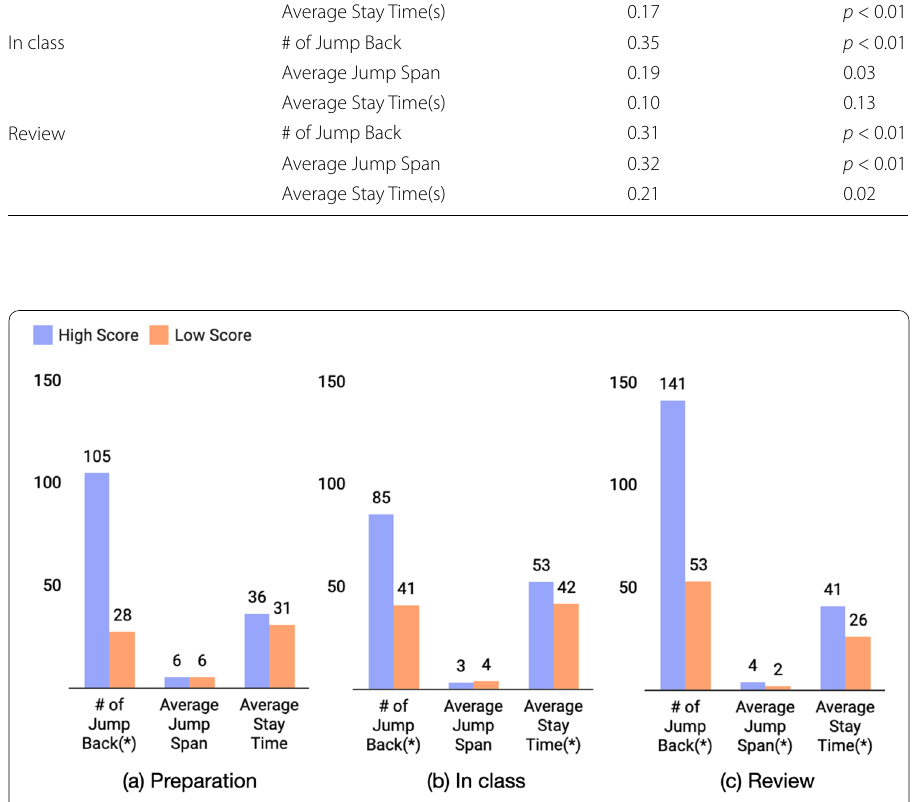
Fig. 9 Comparison results between the high-score group and low-score group. (Significant Level (*) p <